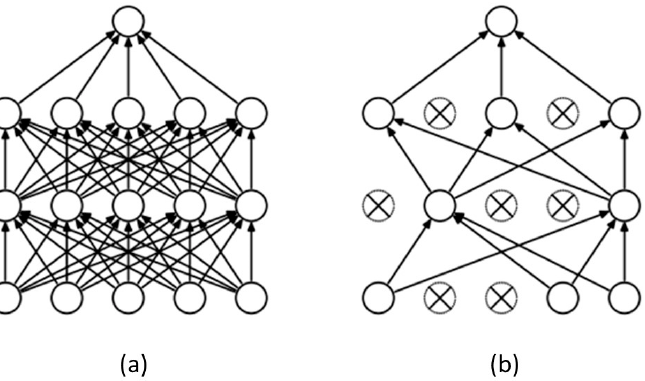
Figure 4. Dropout neural network model. ( a ) Sorting of standard neural network. ( b ) Removal of some cross-terms [24].